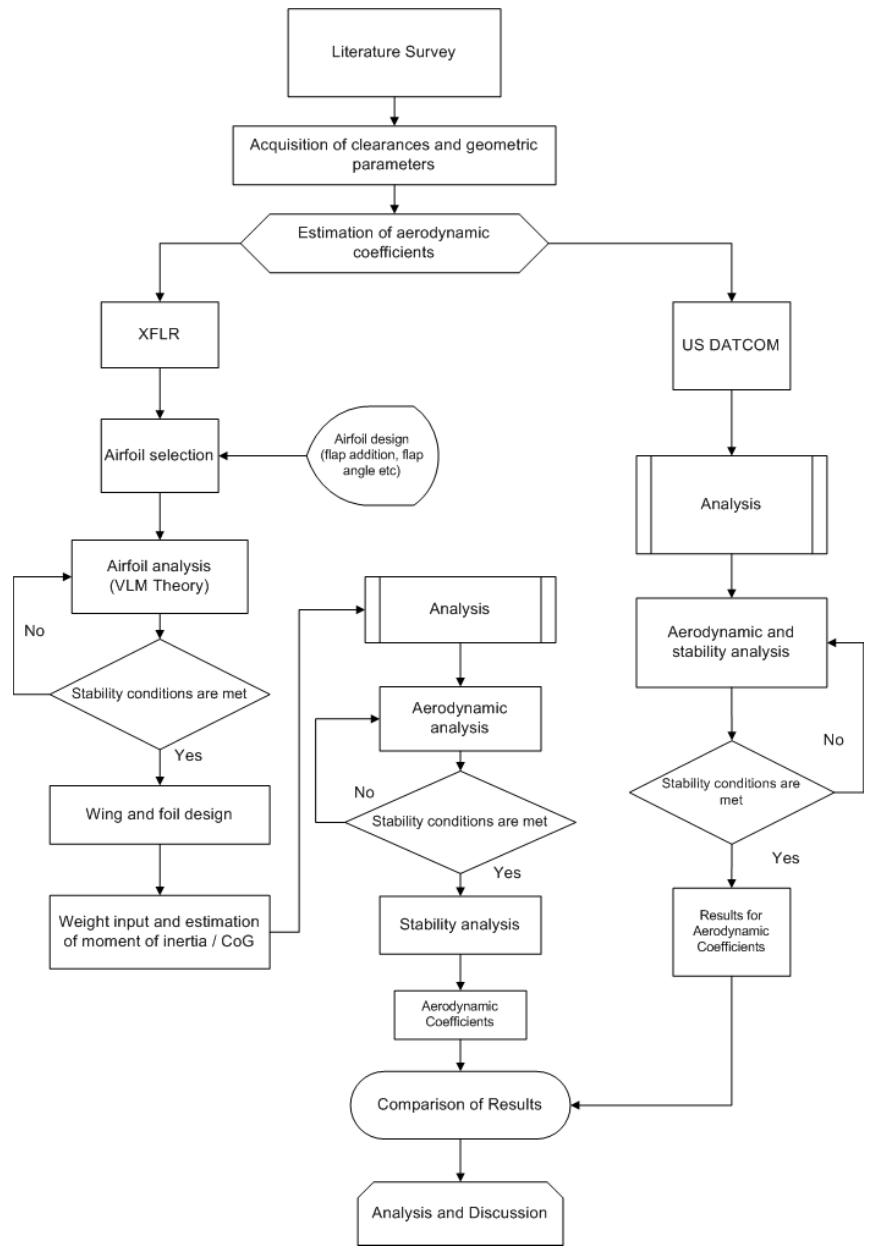
Figure 2. Methodology adopted during the